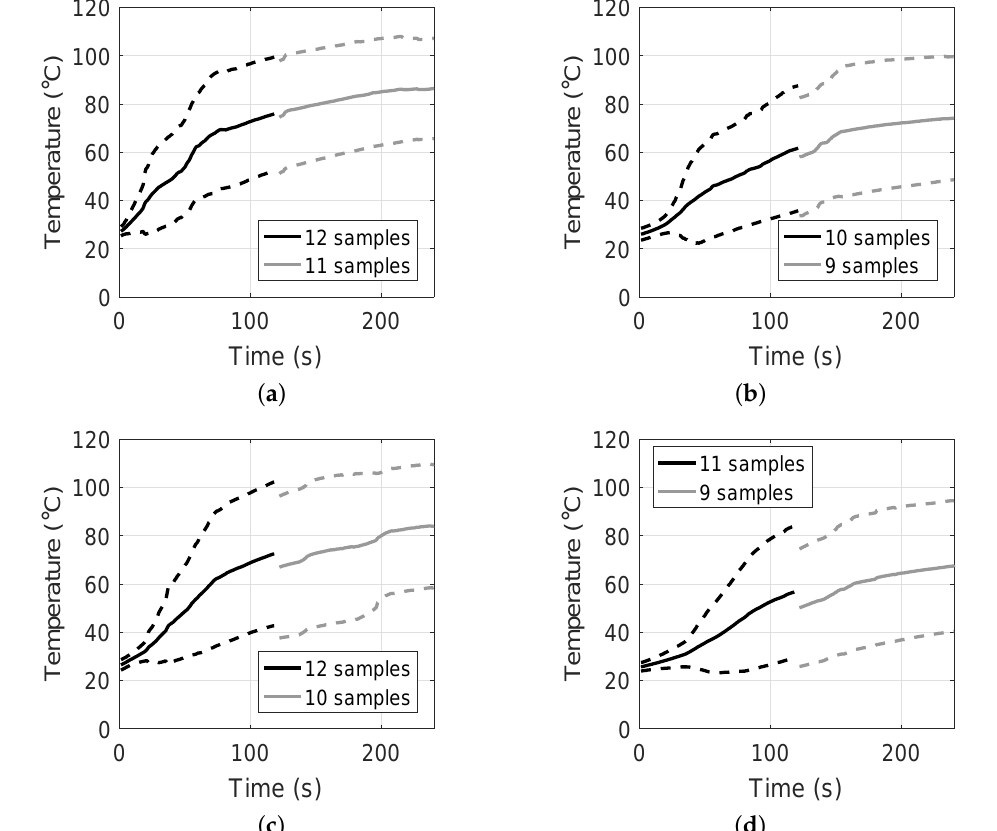
Figure 8. Mean (solid) and standard deviation range (dotted) of temperatures observed at the following locations as a function of time for the first four minutes of MWA. ( a ) 5 mm to the left of the antenna, ( b ) 5 mm to the right of the antenna, ( c ) 10 mm to the right of the antenna, and ( d ) 15 mm to the right of the antenna. The discontinuities are due to the availability of measurement data sets for a larger number of tissue specimens during the first 2 min of ablation. Only measurements from the 12 ablations at 100 W are